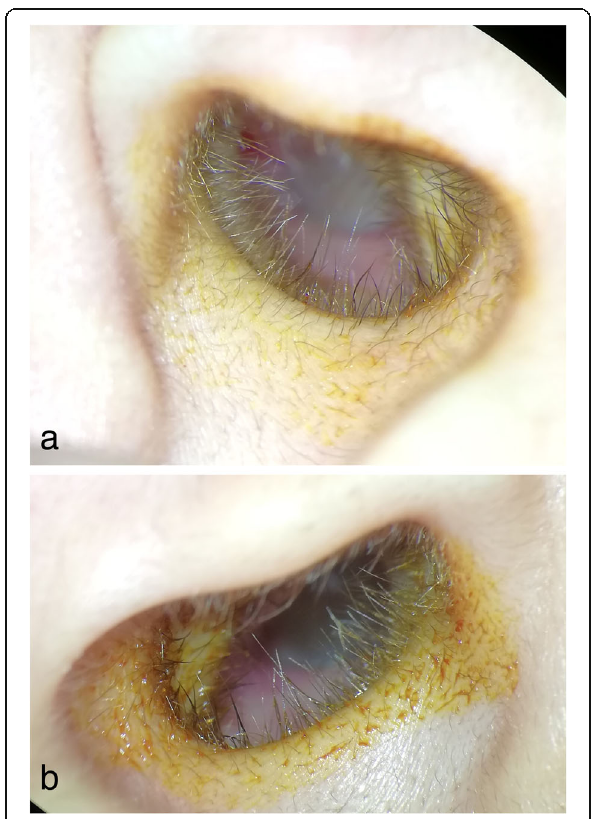
Fig. 1 a Right external ear canal with dried up povidone solution. b Left external ear canal with dried up povidone solution